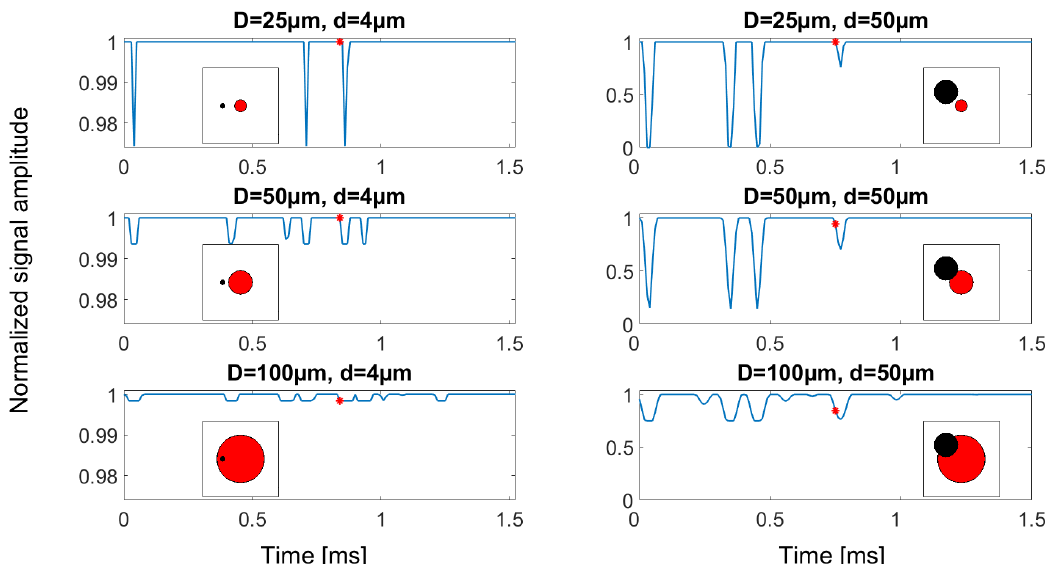
Figure 8. A 1.5ms sequence of the six simulated signals, with inserts showing the particle and aperture position at the sample time indicated by the red *. The vertical axis limits are different for the two particle sizes, in order to be able to compare the output levels for aperture sizes in the case of d = 4µm.